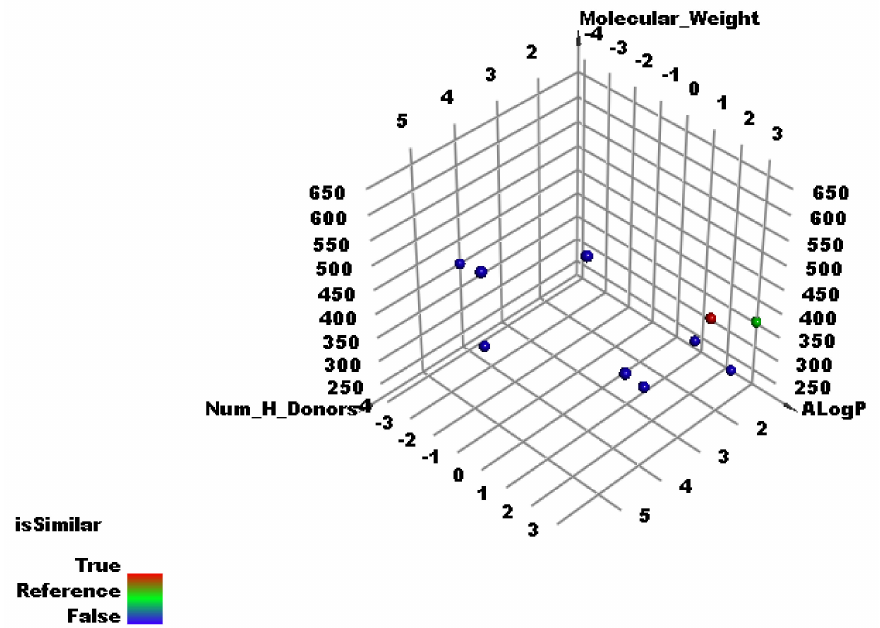
Figure 5. The results of similarity analysis of the examined ligands of SARS-CoV-2 proteins and jusan coumarin.